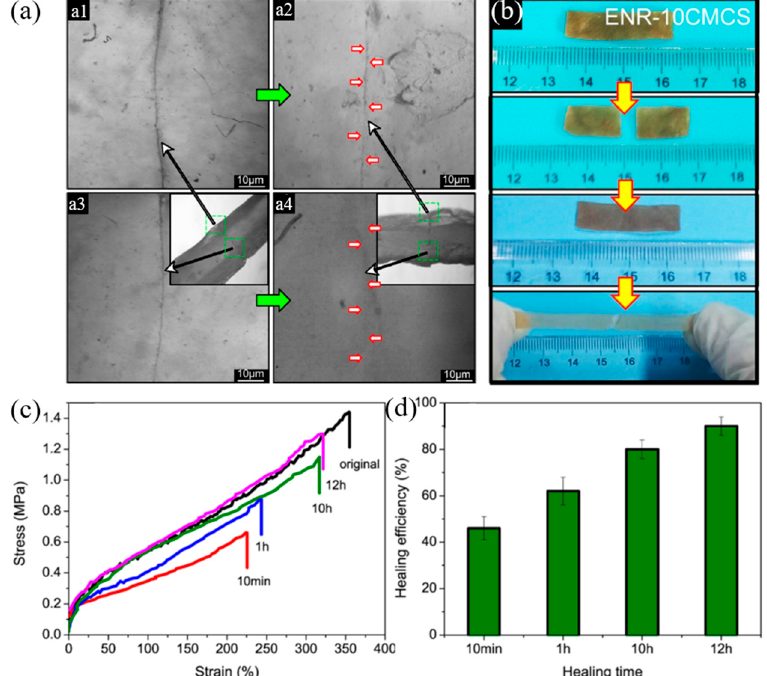
Figure 13. The self-healing microscope and photograph ( a , b ) (( a1 ) the cutting line at the surface before self-healing; ( a2 ) the cutting line at the surface after self-healing; ( a3 ) interior of the cut position before self-healing; ( a4 ) interior of the cut position after self-healin for 12 h at room temperature), stress–strain curves at various healing times ( c ) and healing efficiencies ( d ) of epoxidized natural rubber with carboxymethyl chitosan composites [97]. Adapted with permission from [97]. Copyright 2019 American Chemical Society.